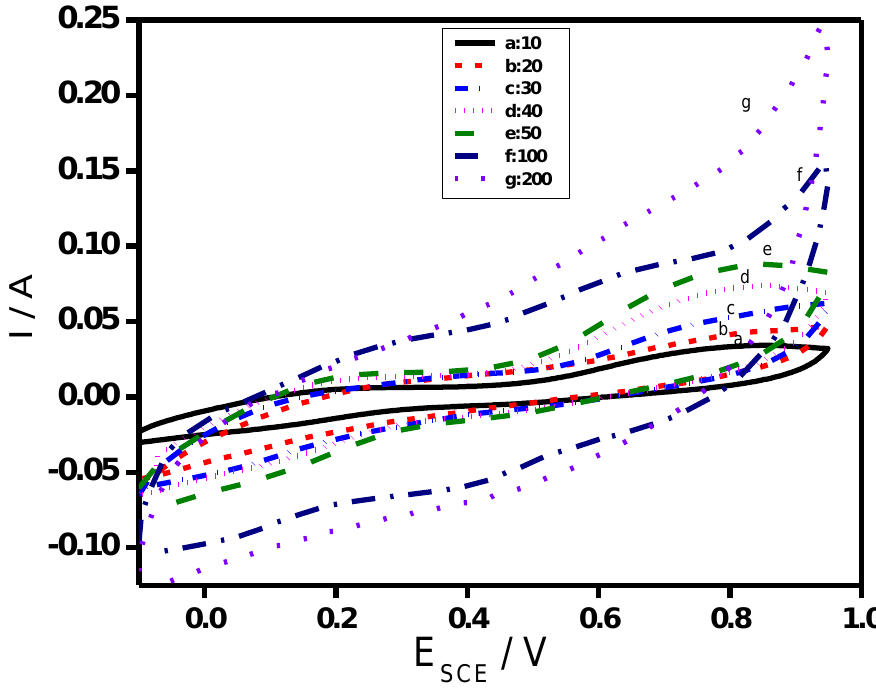
Figure 8. CV curves of RGO / COP composite at various scan rates as indicated.